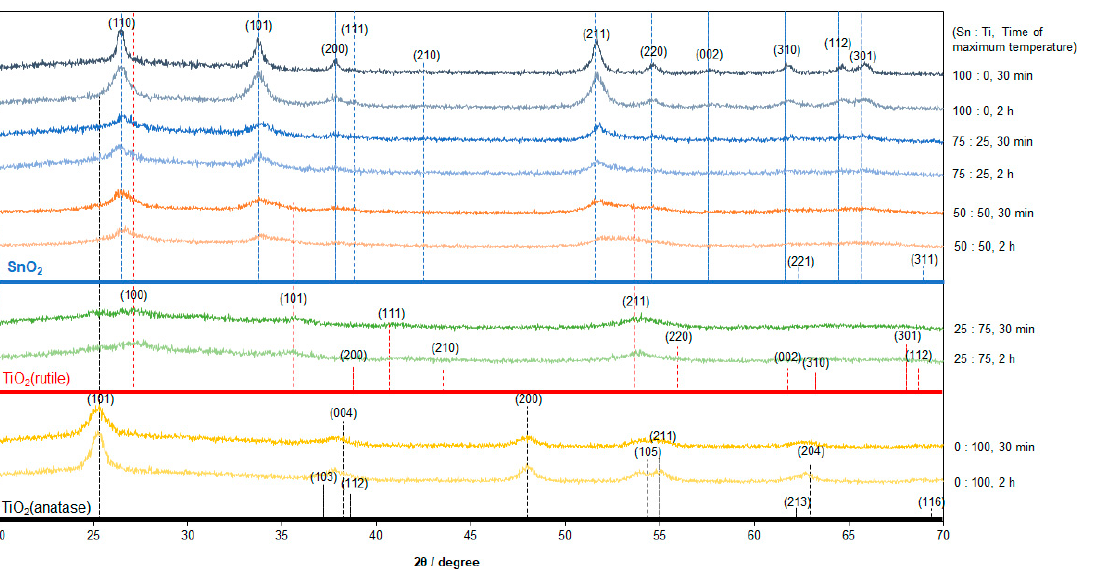
Figure 2. Photos of several Sn/Ti oxides-deposited FTO glass substrates after heat treatment at 500